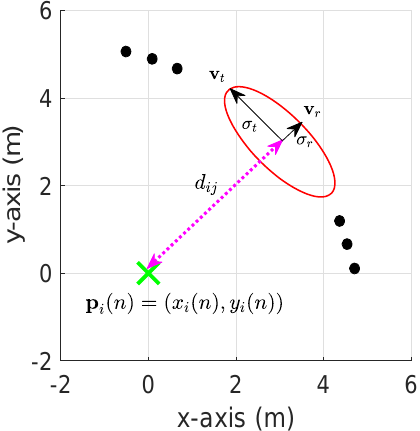
Figure 4. Generation of SoG variables. The dotted magentaline represents the measurement. v r and v t are, respectively, the radial and tangential unit vectors, and σ r and σ t denote, respectively, the radial and tangential standard deviations.